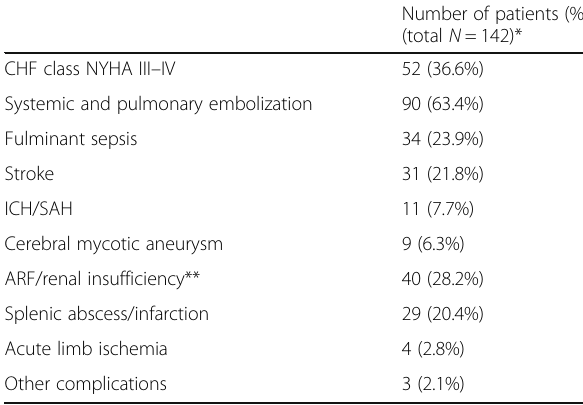
Table 2 Complication frequency in IE patients on admission and during hospitalization